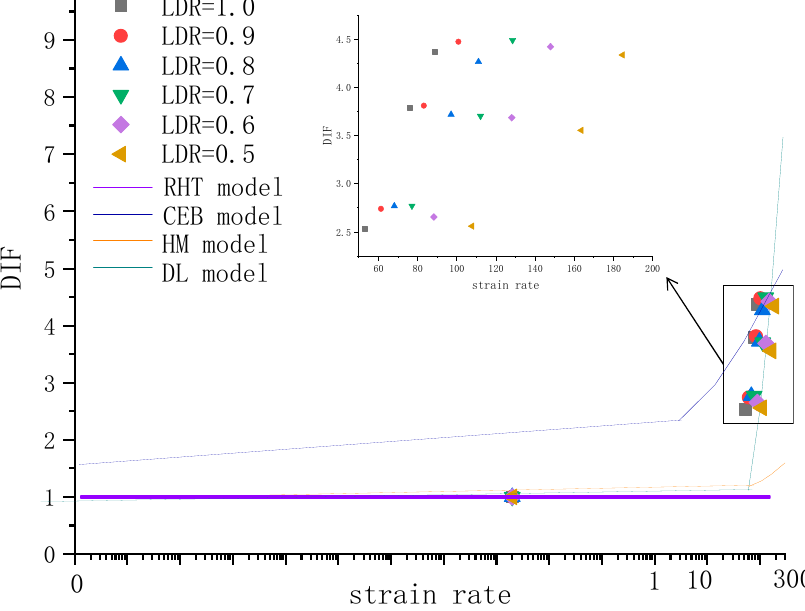
Figure 3. Comparison between experimental DIF values and the empirical model’s values [18,21–23].